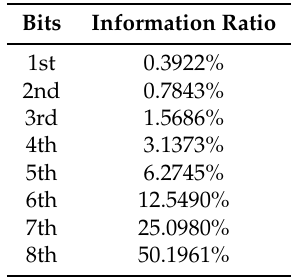
Table 1. Information ratio of different bits in a pixel.